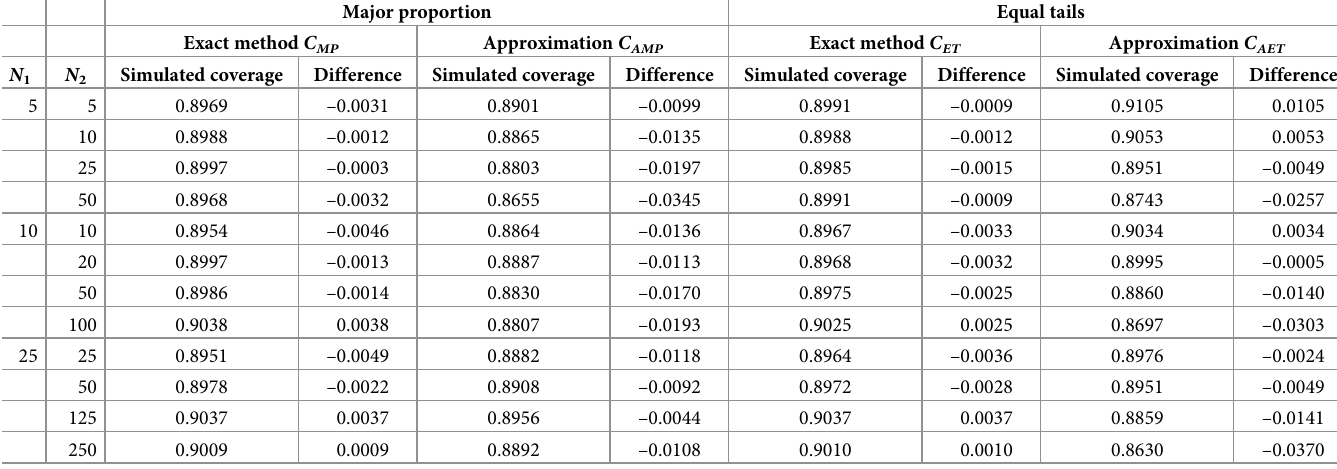
Table 1. The simulated coverage probabilities and errors for the 90% two-sided reference intervals of the distribution proportion